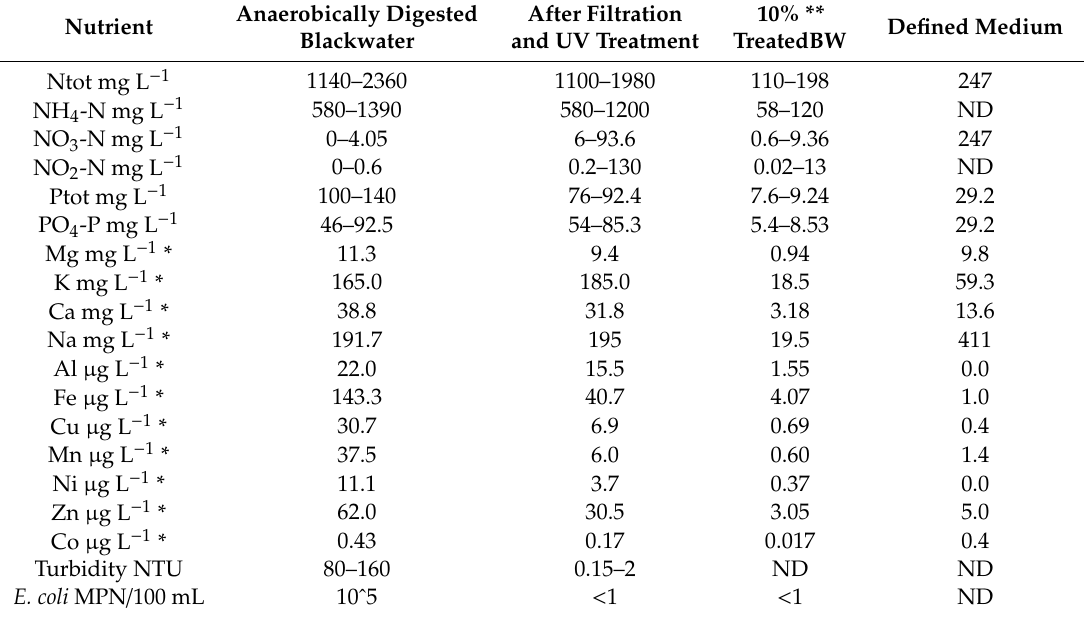
Table 1. Nutrient concentration of anaerobically digested blackwater e ffl uent, e ffl uent after filtration and ultraviolet (UV) treatment and